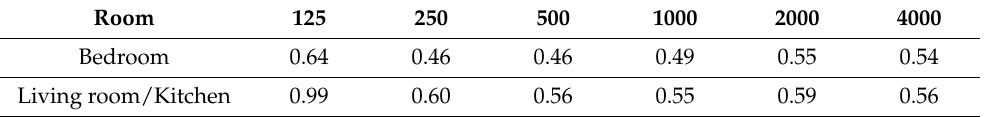
Table 7. Three-room apartment reverberation time T 20 considered in the simulation.